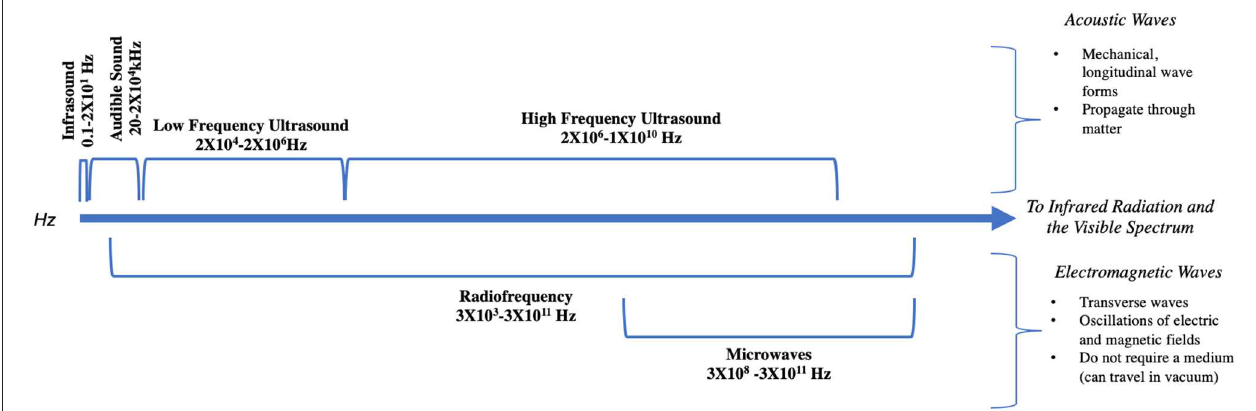
FIGURE 1 | The frequencies of relevant acoustic and electromagnetic